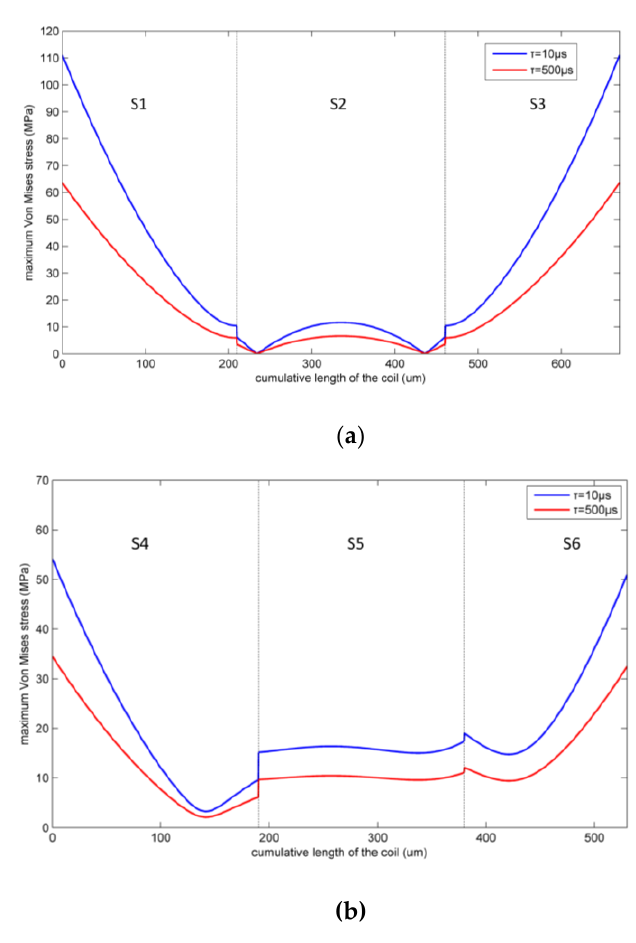
Figure 9. Maximum Von Mises equivalent stress of the inductor under two kinds of shock pulse. ( a ) Part 1; ( b ) Part 2.